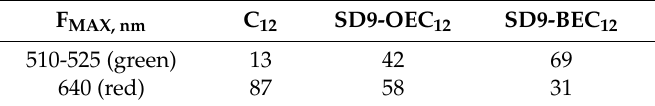
Table 1. Relative ratios of fluorescence intensities for “green” and “red” emitters obtained from spectra recorded using 254 nm excitation. The numbers were obtained as areas under the Gaussian fits to intensity of fluorescence plotted vs. energy (shown in Supplementary Figure